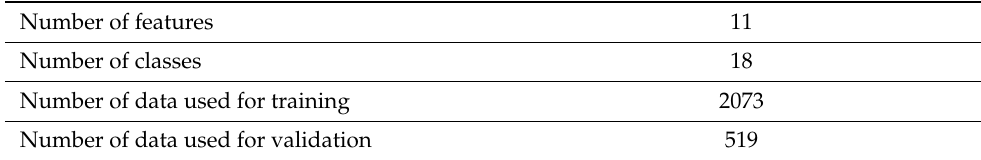
Table 3. Information of the amount of data used in the artificial neural network classifier. Number of